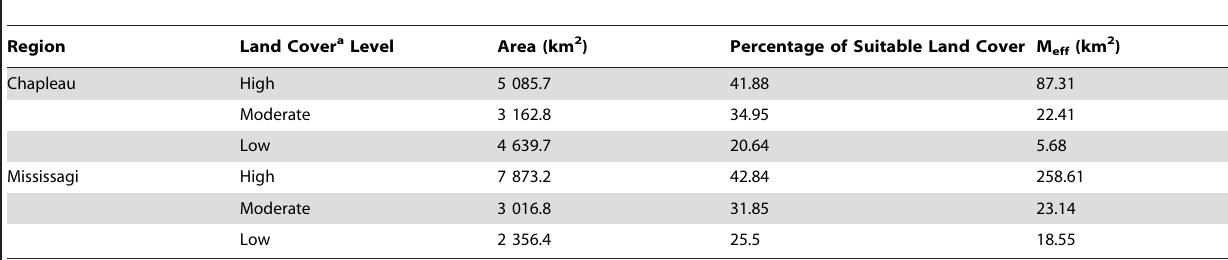
Table 1. Summary of the amount of suitable land cover and habitat fragmentation across two regions in the southern boreal forest in Ontario,